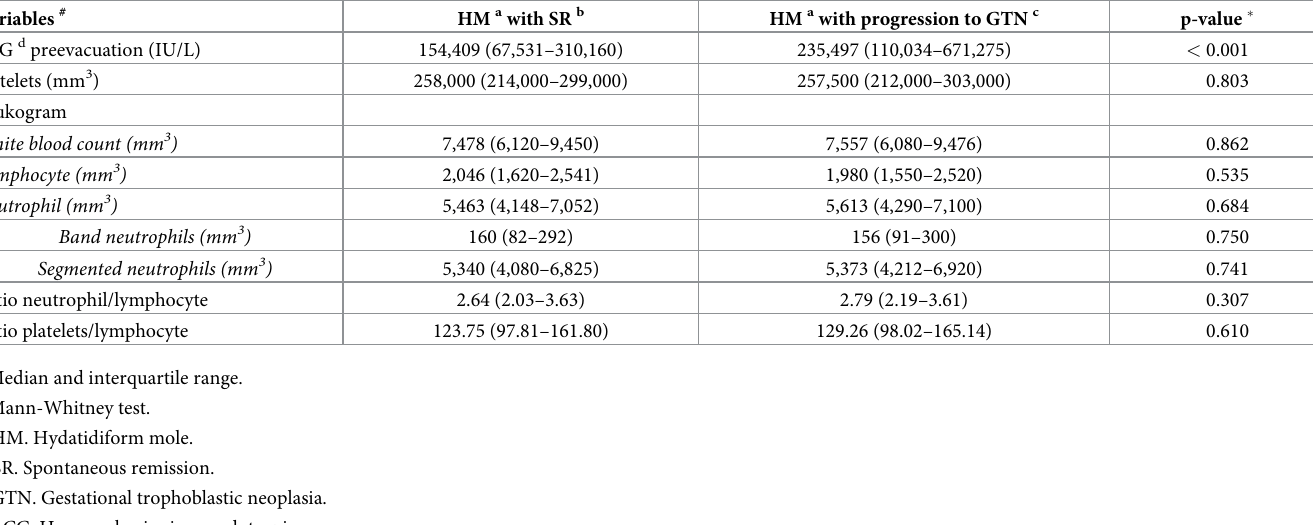
Table 2. Laboratory findings of patients with complete hydatidiform mole associated with spontaneous remission or progression to gestational trophoblastic